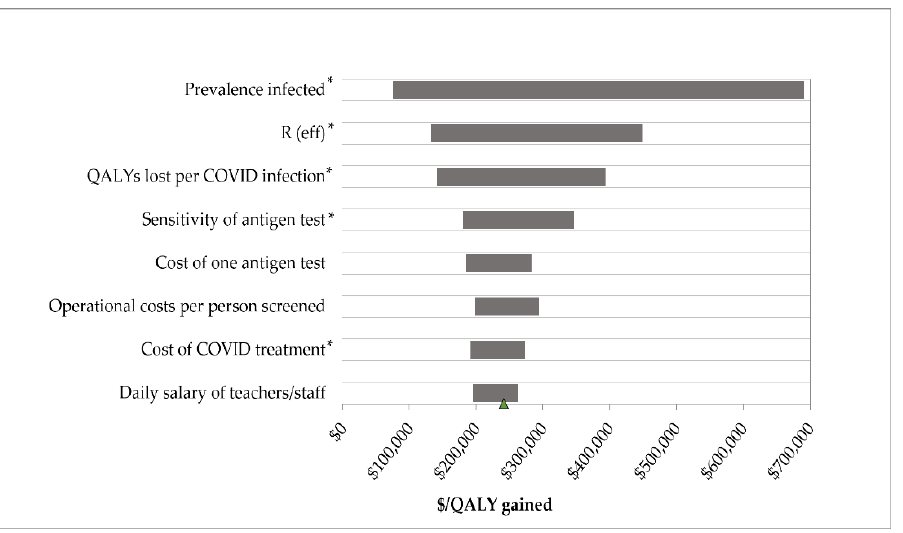
Figure 1. Tornado diagram: one-way sensitivity analyses on the societal incremental cost-effectiveness ratio (ICER) of once weekly antigen testing with confirmatory PCR compared to no test. ICER ranges from USD 76,000 to USD 691,000 per QALY gained. Ag: antigen test, ICER: incremental cost-effectiveness ratio, QALY: quality-adjusted life year, PCR: polymerase chain reaction test, R(eff): effective reproduction number. * Input is inversely associated with ICER.